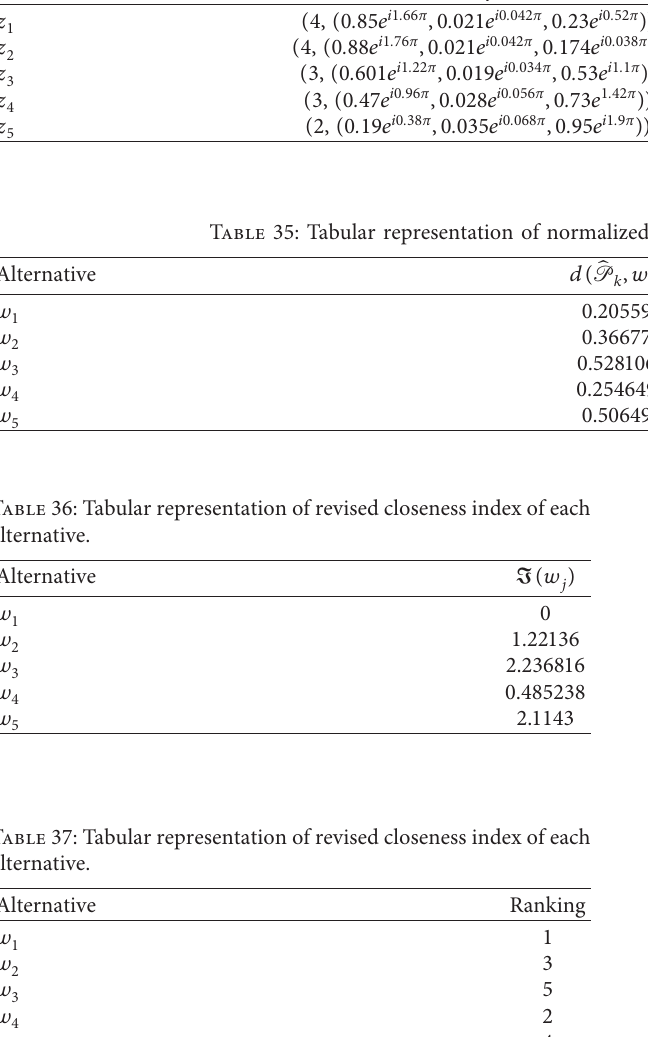
Table 34: Tabular representation of CSFNS